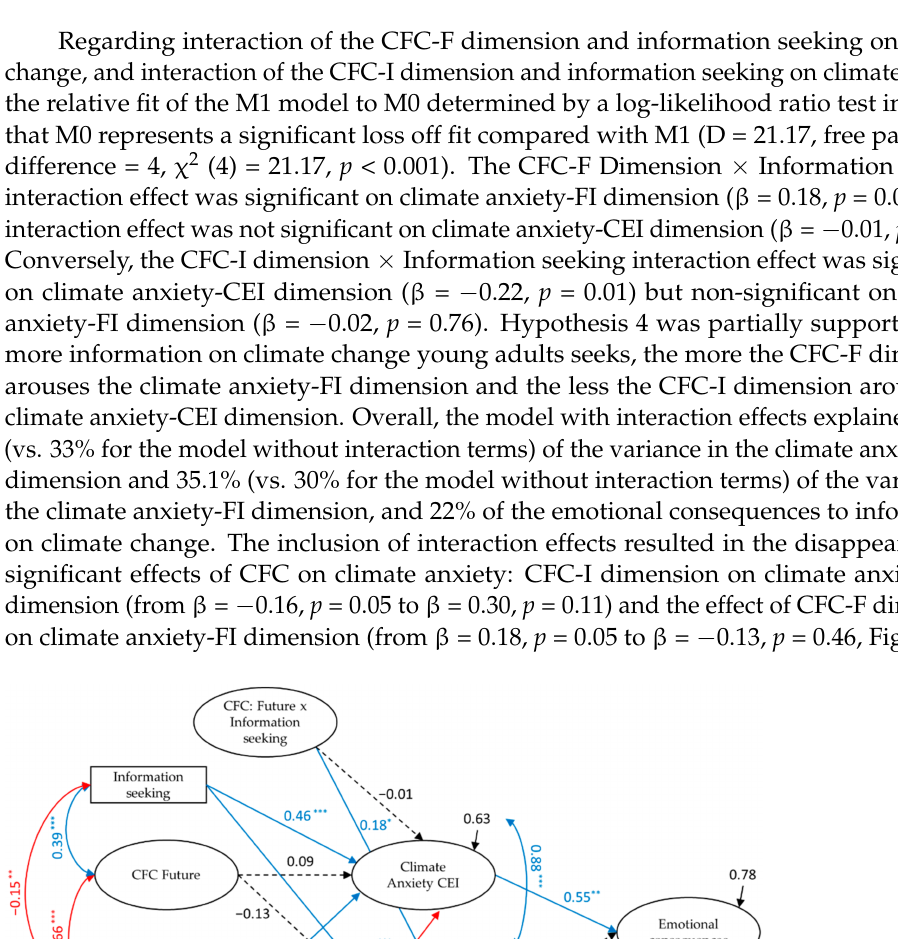
Figure 2. Standardized Estimates from Structural Equation Model. Latent factor indicators not shown for clarity. Blue arrows represent positive relationships. Red arrows represent negative relationships. Black dashed arrows represent non-significant relationships. * p < 0.05. ** p < 0.01. *** p < 0.001.